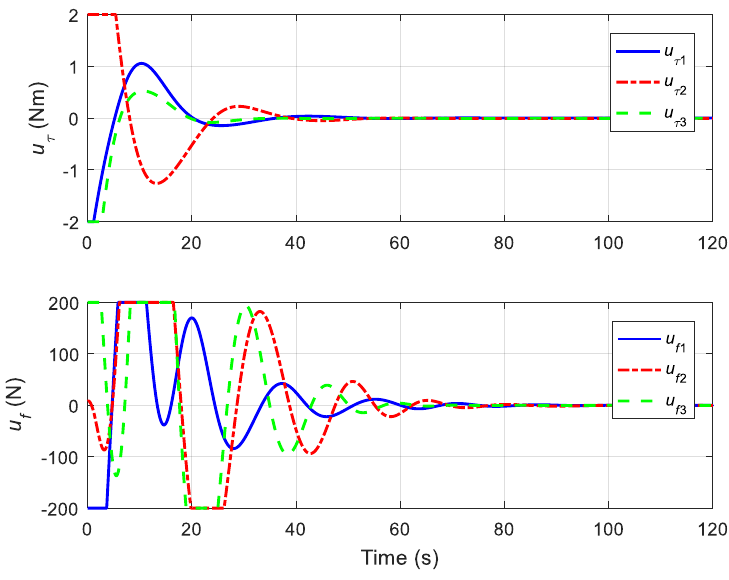
Figure 9. Relative position and velocity under the PD controller.